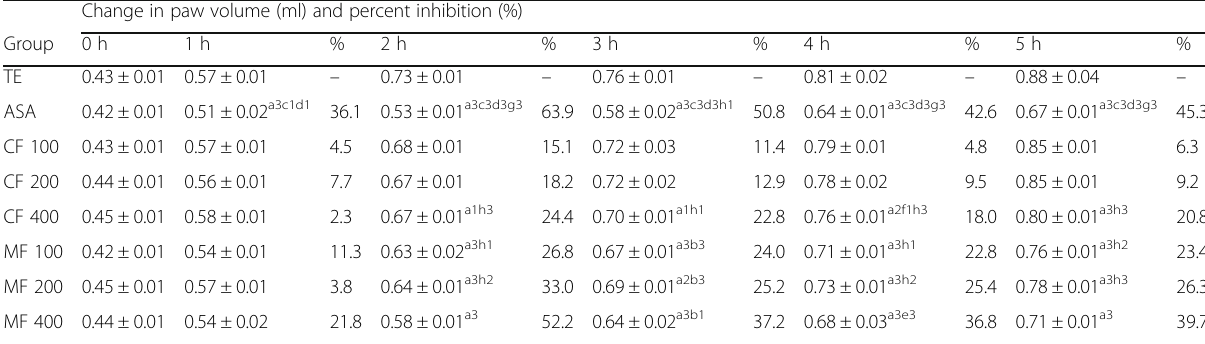
Table 5 Effects of the chloroform and methanol fractions of Moringa stenopetala on carrageenan- induced paw edema and percent inhibition from increase in paw volume Change in paw volume (ml) and percent inhibition (%)